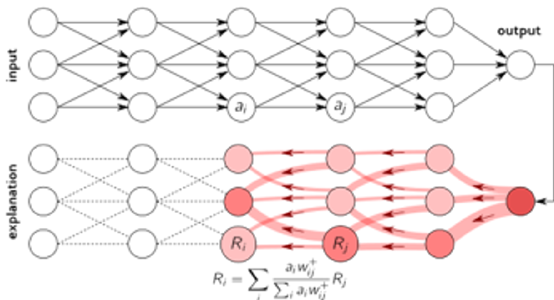
Figure 3. Structure for the LRP [41].